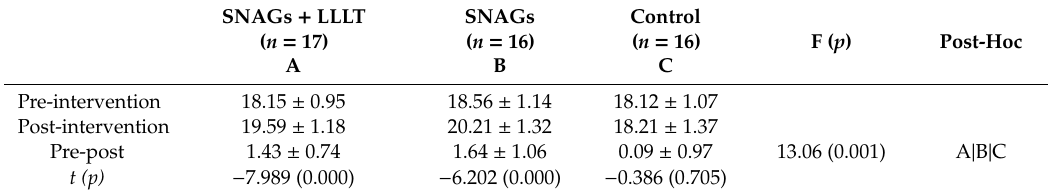
Table 3. Di ff erence on the range of motion ( N = 49).